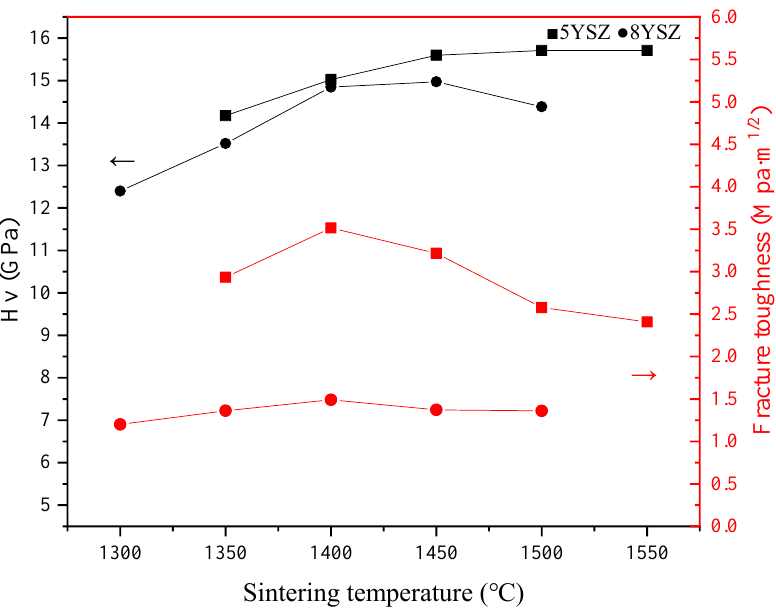
Figure 6. Change trend of hardness and fracture toughness with temperature under CS process. Table 3. Relationship between mechanical properties, relative density, and grain size of different samples at 2 h holding